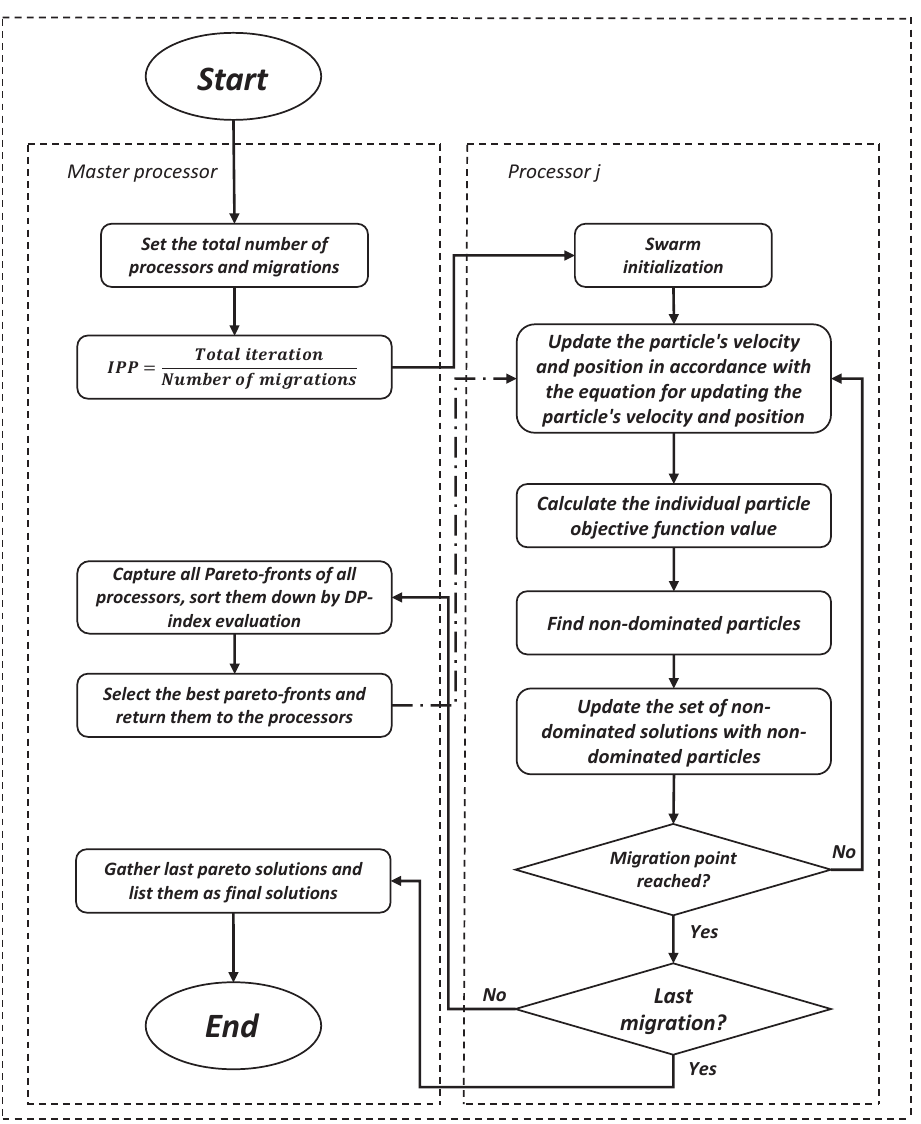
Figure 1. The flow chart of the parallel multi-objective PSO